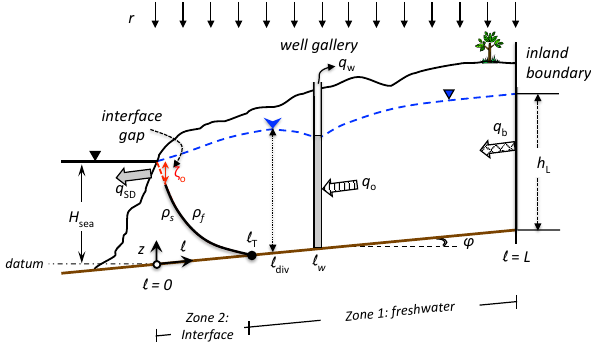
Fig. A1. Sharp-interface conceptualization of seawater intrusion in an inclined unconfined coastal